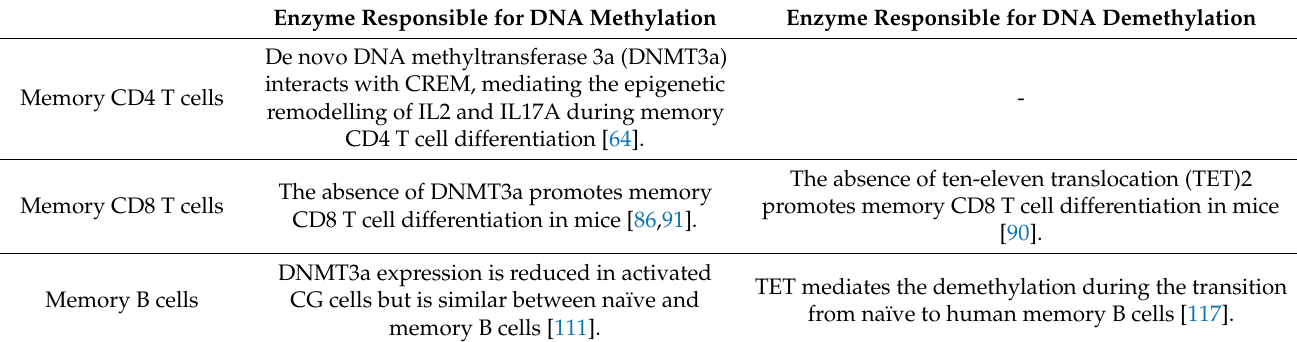
Table 1. Role of the enzymes that regulate DNA methylation during memory T cell differentiation. Enzyme Responsible for DNA Methylation Enzyme Responsible for DNA Demethylation